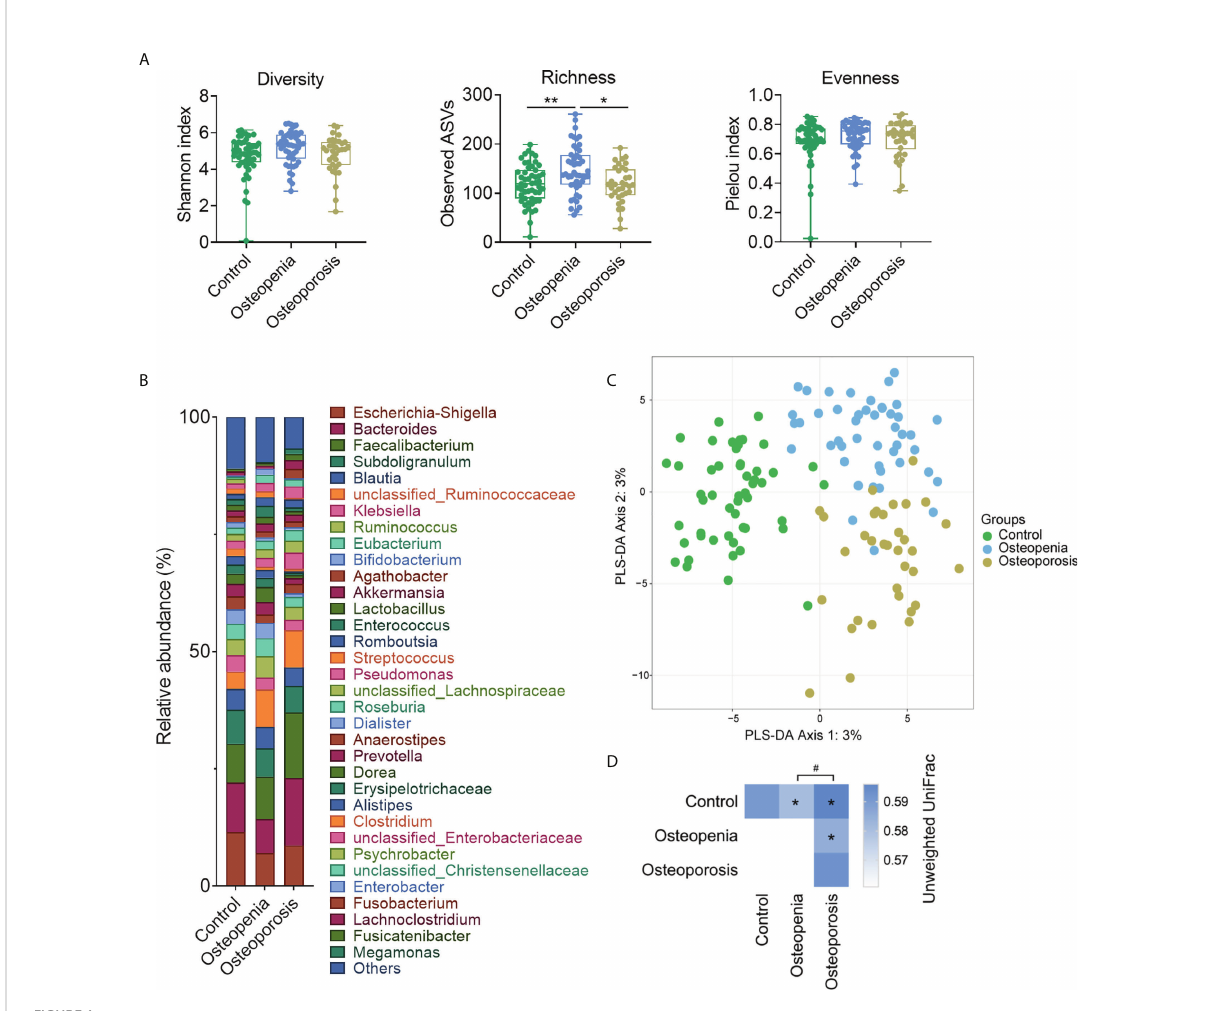
FIGURE 1 Structure and composition of GM among the control, osteopenia, and osteoporosis groups. (A) Diversity, richness, and evenness of GM in the groups. (B) Bar plot showing the relative abundance of each genus. Only genera whose average relative abundances are greater than 1% among the samples are shown. (C) PLS-DA plot. (D) PERMANOVA test results based on the unweighted UniFrac distance of GM and comparison of unweighted UniFrac distances between the microbiota of women in the osteopenia, osteoporosis, and control groups. * and ** represent PERMANOVA p -values <0.05 and <0.01, respectively. # represents p < 0.05 from the Wilcoxon rank-sum test of the